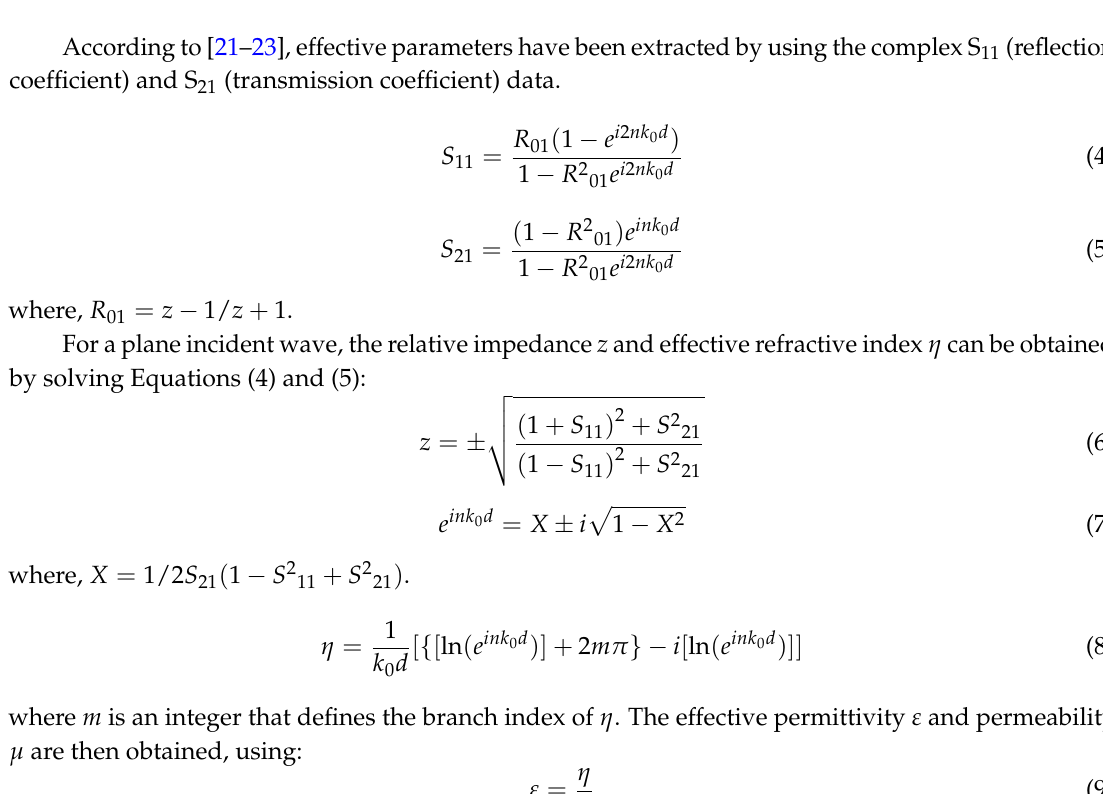
Figure 2. ( a ) Floquet port setup; ( b ) measurement setup.